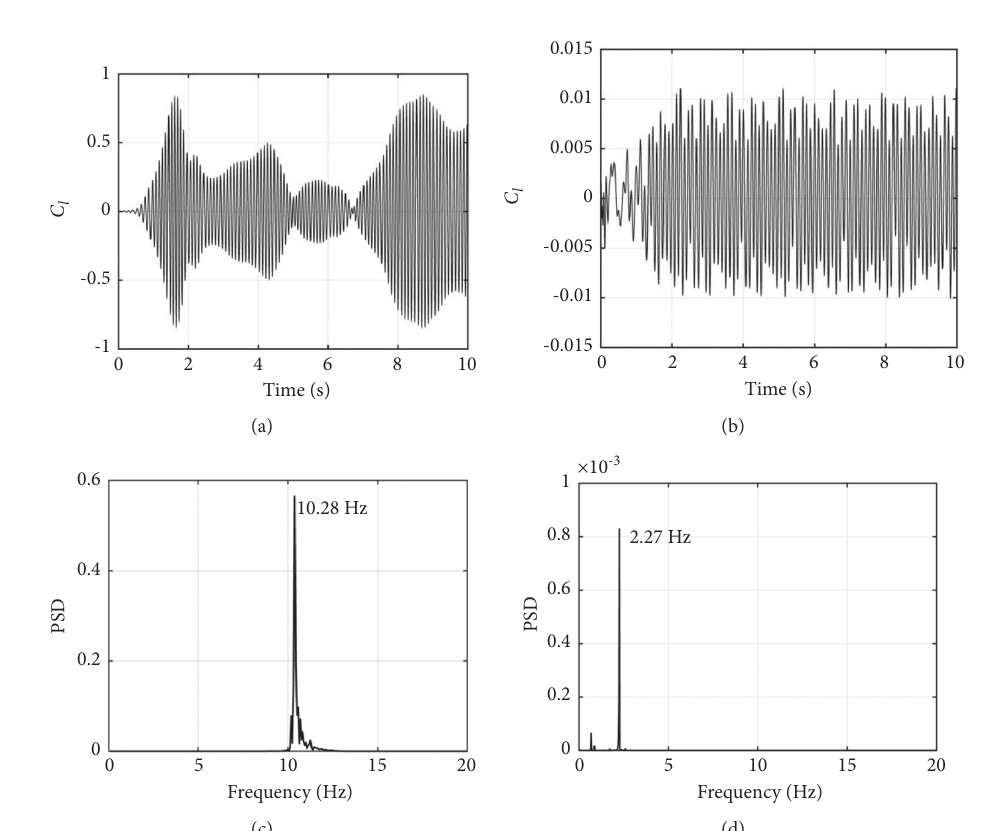
Figure 15: The layout of Example 1.